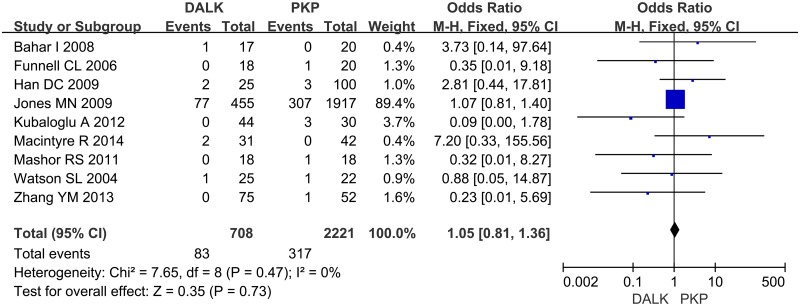
Forest plot comparing the rate of graft failure between DALK and PK.CI = confidence interval; SD = standard deviation; DALK = deep anterior lamellar keratoplasty; PK = penetrating keratoplasty.